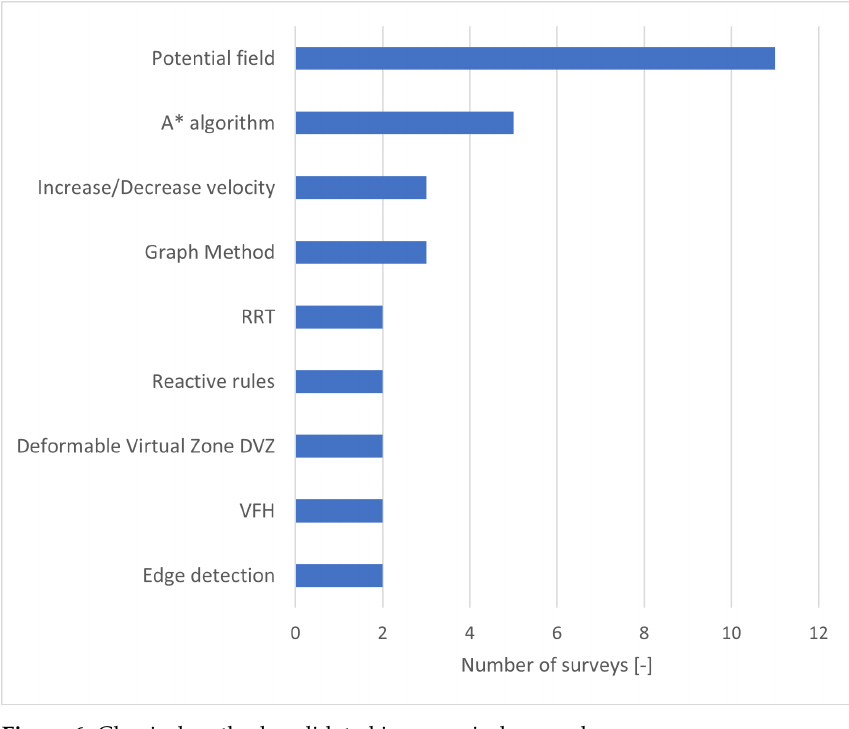
Figure 6. Classical methods validated in numerical research.